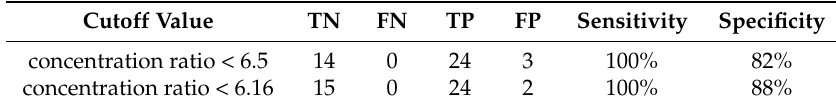
Table 2. Sensitivity and specificity